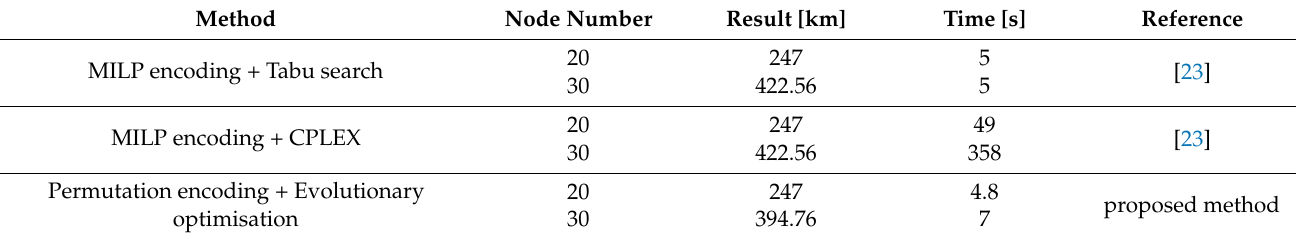
Table 3. Comparison of the results obtained with the proposed method with the results published in the literature.